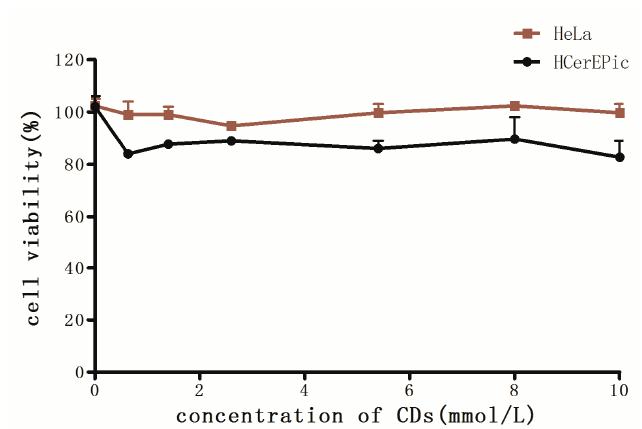
Figure 4. Cell Counting Kit 8 (CCK-8) assay was used to examine the effects of N-CQDs with different concentrations on the survival rate of two kinds of cells.